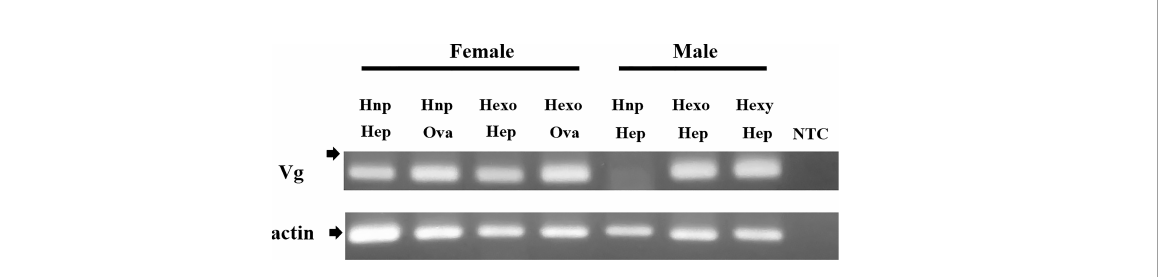
FIGURE 7 Induction of expression of vitellogenin gene in the male thukuhar shore-crab ( Metopograpsus thukuhar ) parasitized by Polyascus planus . Total RNA prepared from the tissues as indicated (Hep: hepatopancreas; Ova: Ovary) was reverse transcribed and the cDNA ampli fi ed with primers as speci fi ed in the Materials and methods. The expected size of the amplicons is 136 bp for Vg and 193 bp for actin. Arrows point to the location of a 200-bp marker. Sequence of the amplicons has been veri fi ed by DNA sequencing. Hnp: non-parasitized hosts; Hexo, Hexy: hosts bearing orange and yellow externa, respectively. NTC; no template control that did not contain any template DNA. Note especially that the Vg amplicon is ampli fi ed in the hepatopancreas of the parasitized male, but not in that of non-parasitized